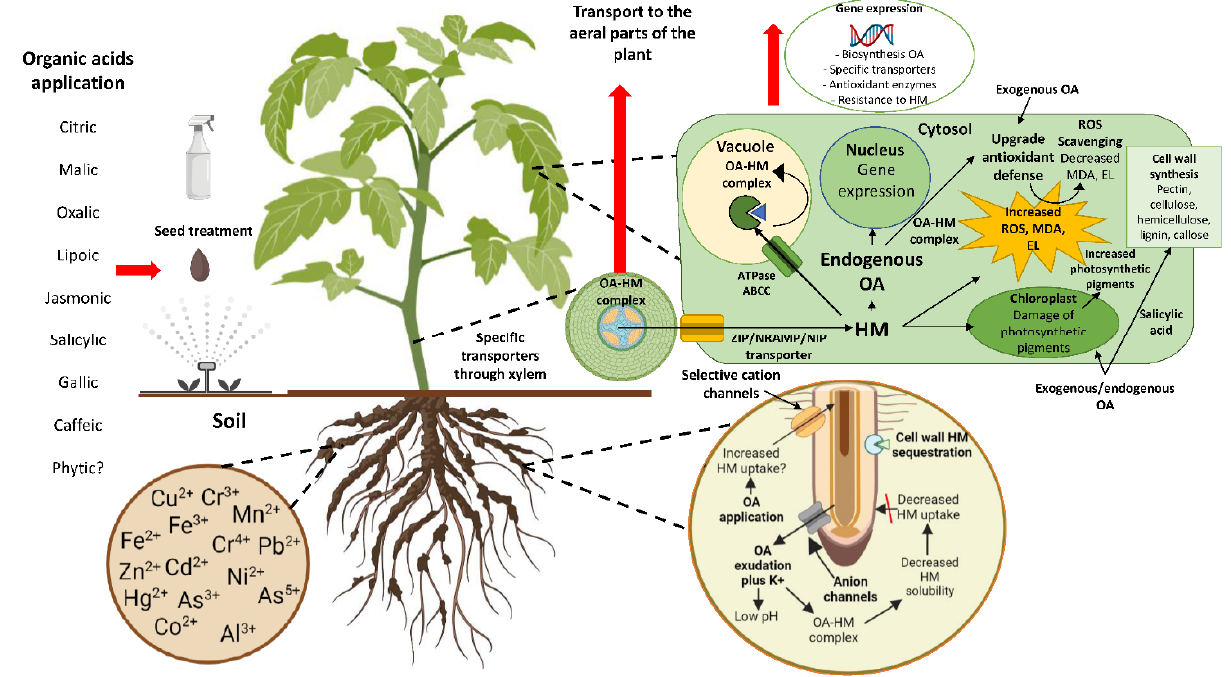
Figure 1. Potential molecular and physiological mechanisms triggered by the exogenous application of organic acids that increase the tolerance of plants to heavy metal stress.